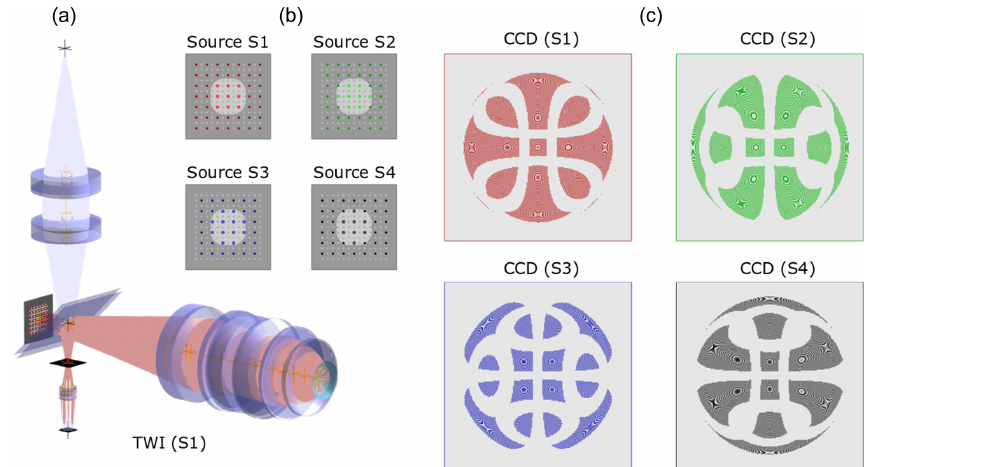
Figure 4. Examples from the tilted-wave interferometer (TWI) simulation. (a) Ray paths through the instrument. Source array, reference and test arms, and detector (CCD). (b) The sources of the laser array are switched on in four groups (S1 to S4); (c) simulated interferograms on the CCD for each of the source groups for an asphere